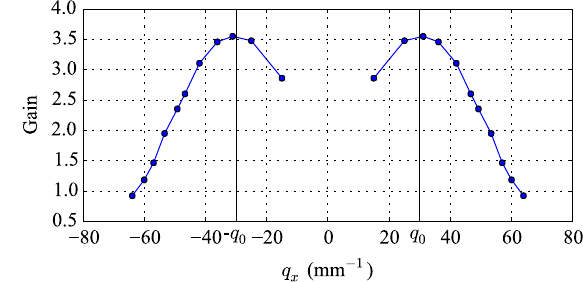
FIG. 3. Spatial gain spectrum as inferred from the spatial gain profile in the far field. The probe field is seeded with a Gaussian beam at a variable angle with the pump beam, and the ratio between the seed power and output probe power is measured. The profile has been measured along the x direction but would be the same along any radial direction. The gain at low q accurately measurable due to pump light leakage at q